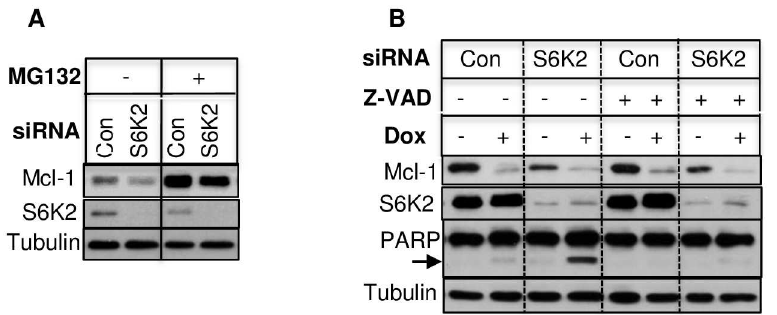
Fig 4. Effects of proteasome inhibitor and caspase inhibitor on Mcl-1 downregulation. (A). T47D cells were transfected with indicatedsiRNAs. 48 h after transfection, cells were treated with or without 5 μ M MG132 for 24 h and Western blot analysiswas performed. (B). T47D cells transfected with indicatedsiRNAs for 48 h were pretreatedwith or without 25 μ M z-VAD-fmk prior to treatment with 10 μ M doxorubicin for 24 h, and Western blot analysiswas performed. Tubulin was used to check for equal